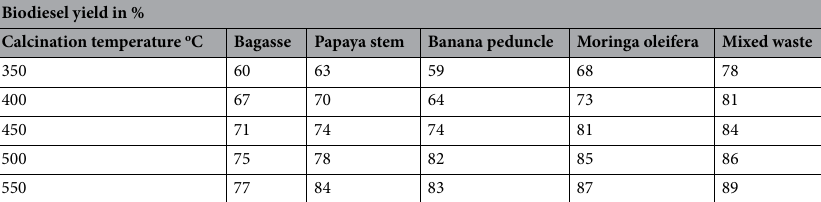
Table 1. Calcination temperature effects in biodiesel